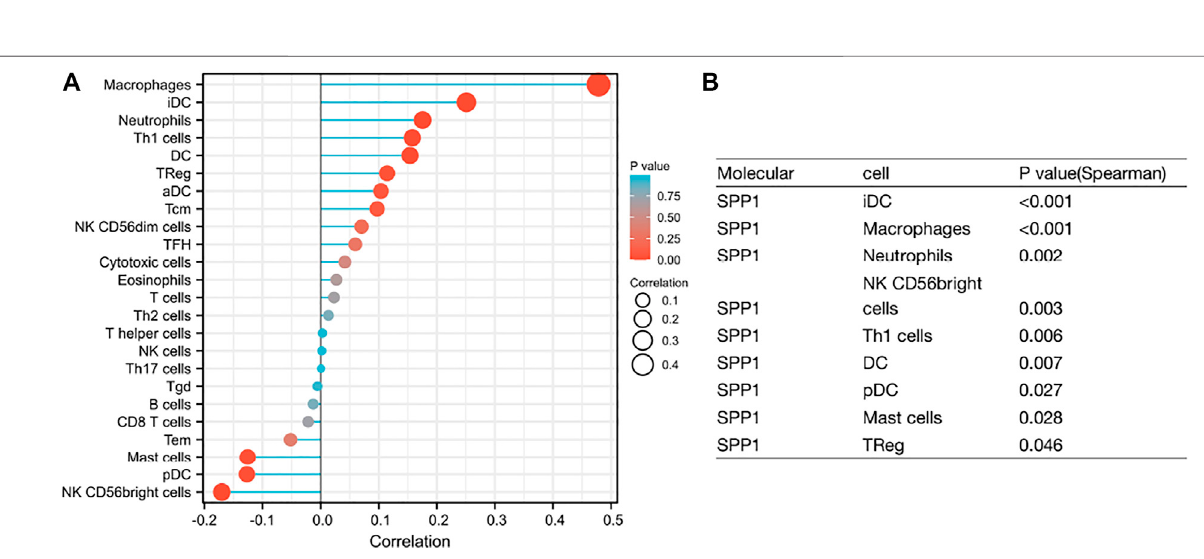
FIGURE6|(A) Lollipopchartof SPP1 expressionlevelin24immunecells. (B) Theimmunecellin fi ltrationassociatedwith SPP1 expression,P < 0.05,representsa signi fi cant